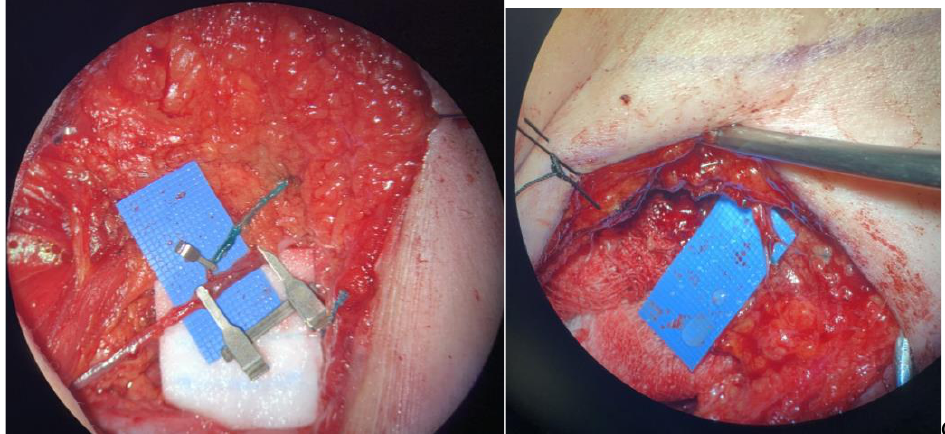
Figure 3. ( A ): Identification of a lymphatic channel. ( B ): Identification of suitable vein. ( C ): Preparing for an end to side lymphaticovenous anastomosis; picture on right shows multiple tiny intussuscepted lymphatics end to end into a recipient vein.